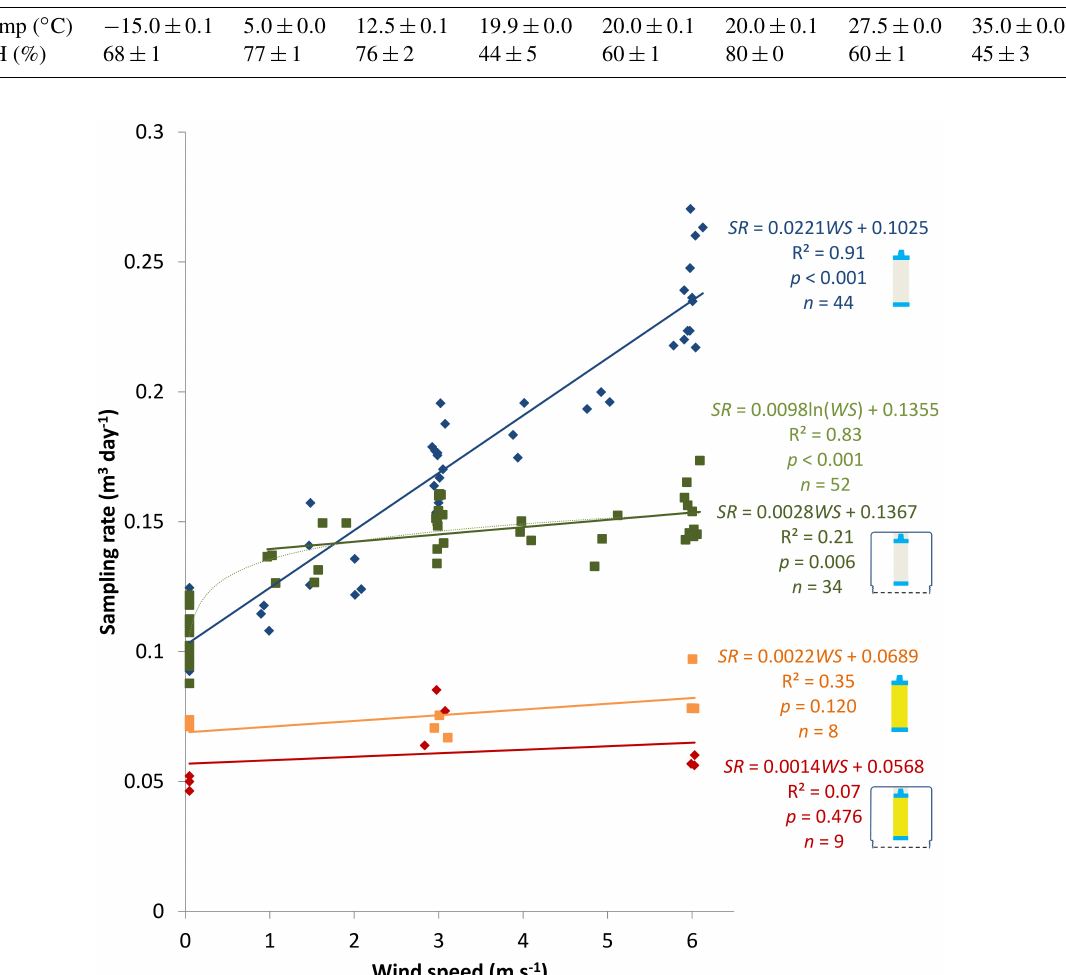
Table 1. Combinations of temperature and relative humidity during the eight experiments performed in climate-controlled chambers. The three relative humidity treatments were 44, 60, and 80% while the temperature was held constant at 20 ◦ C. All treatments were used for the temperature experiments.